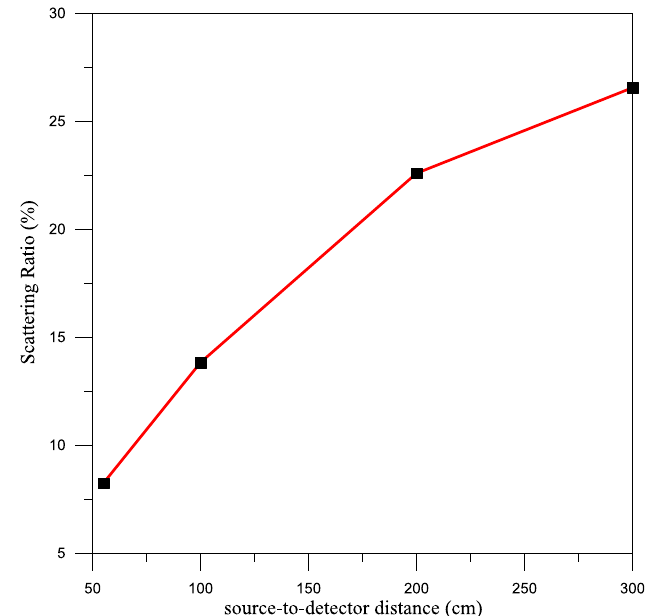
Fig. 5. The neutron scattering ratios with source to detector distances.